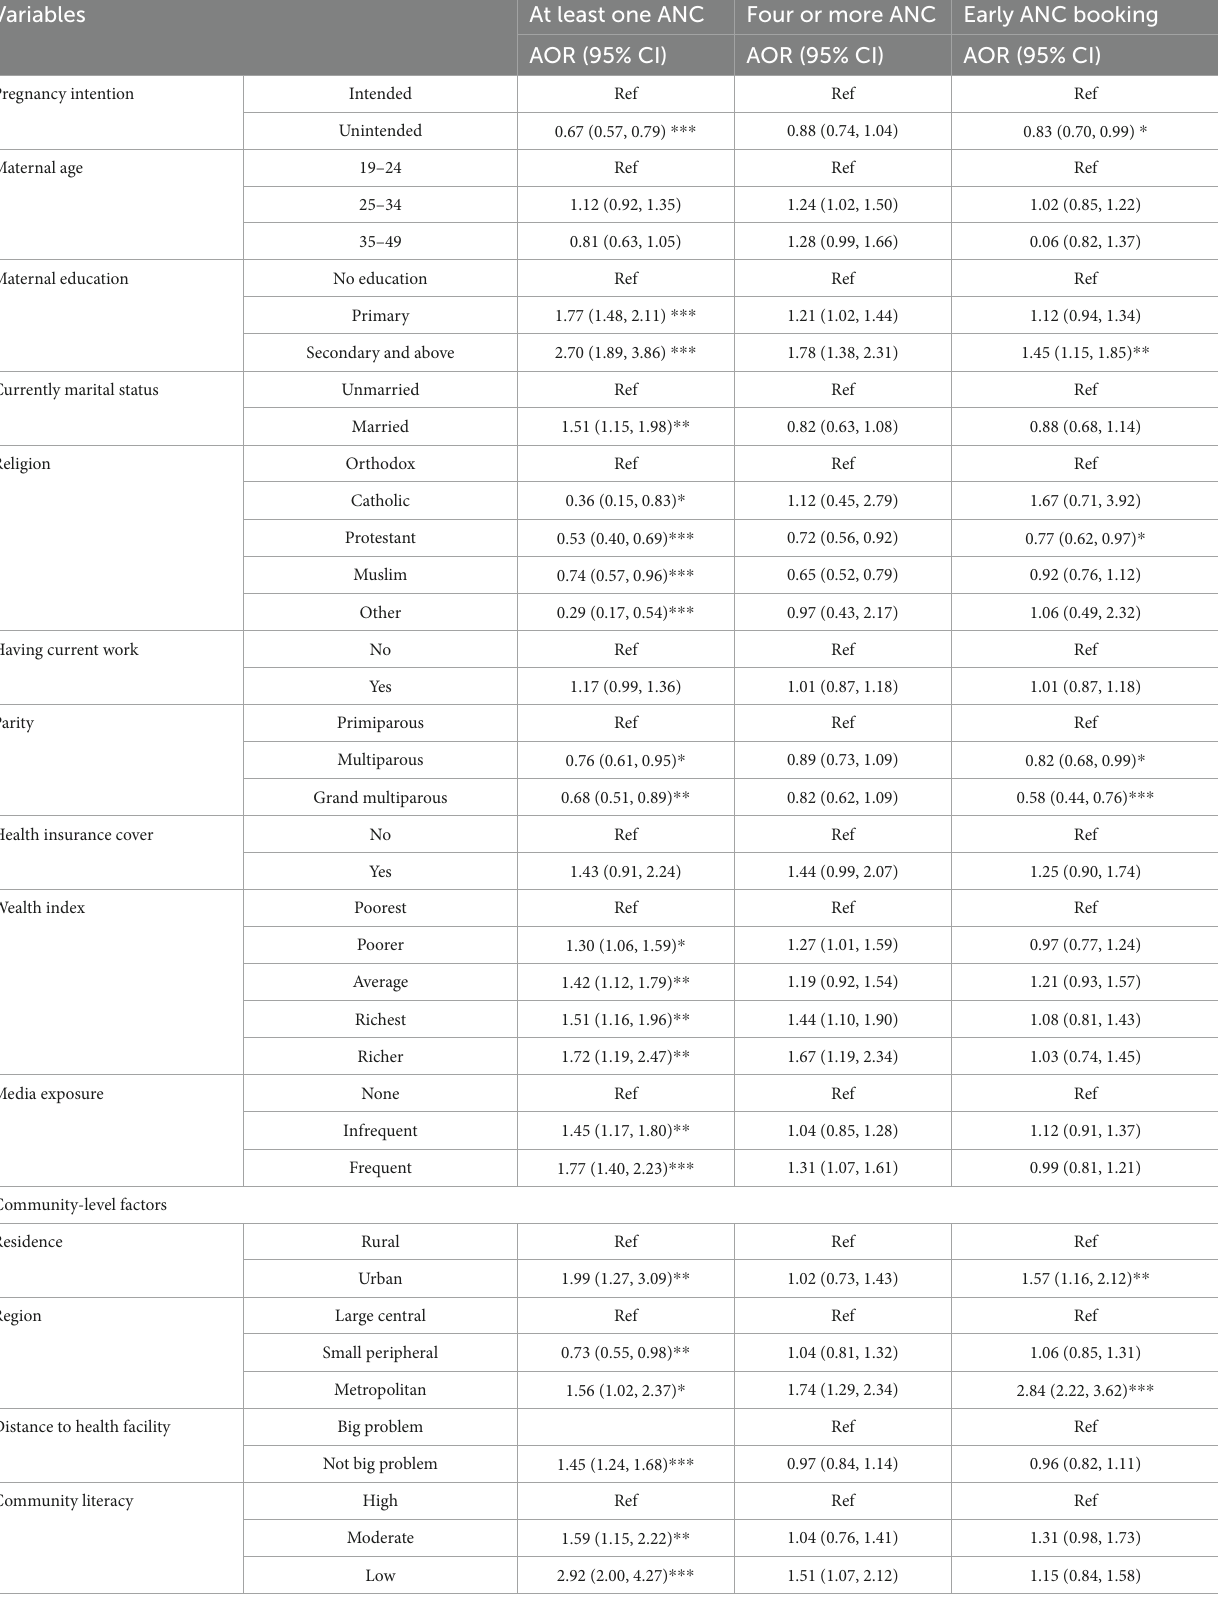
TABLE 2 Multilevel modeling to determine the relationship between unintended pregnancy and use of at least one ANC, use of four or more ANC visits, and early ANC booking in Ethiopia using 2016 EDHS.